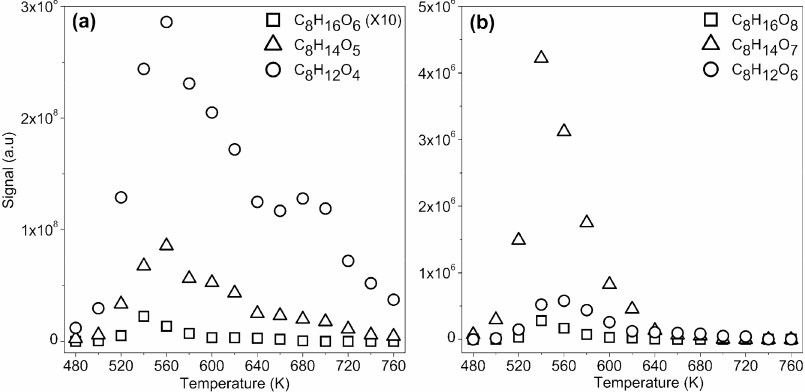
Figure 5. Experimental UHPLC-HRMS signal profiles for multi-oxygenated molecules formed during the low-temperature oxidation of di-n-butyl ether: ( a ) C 8 H 16 O 6 (negative APCI, C 8 H 15 O 6 −